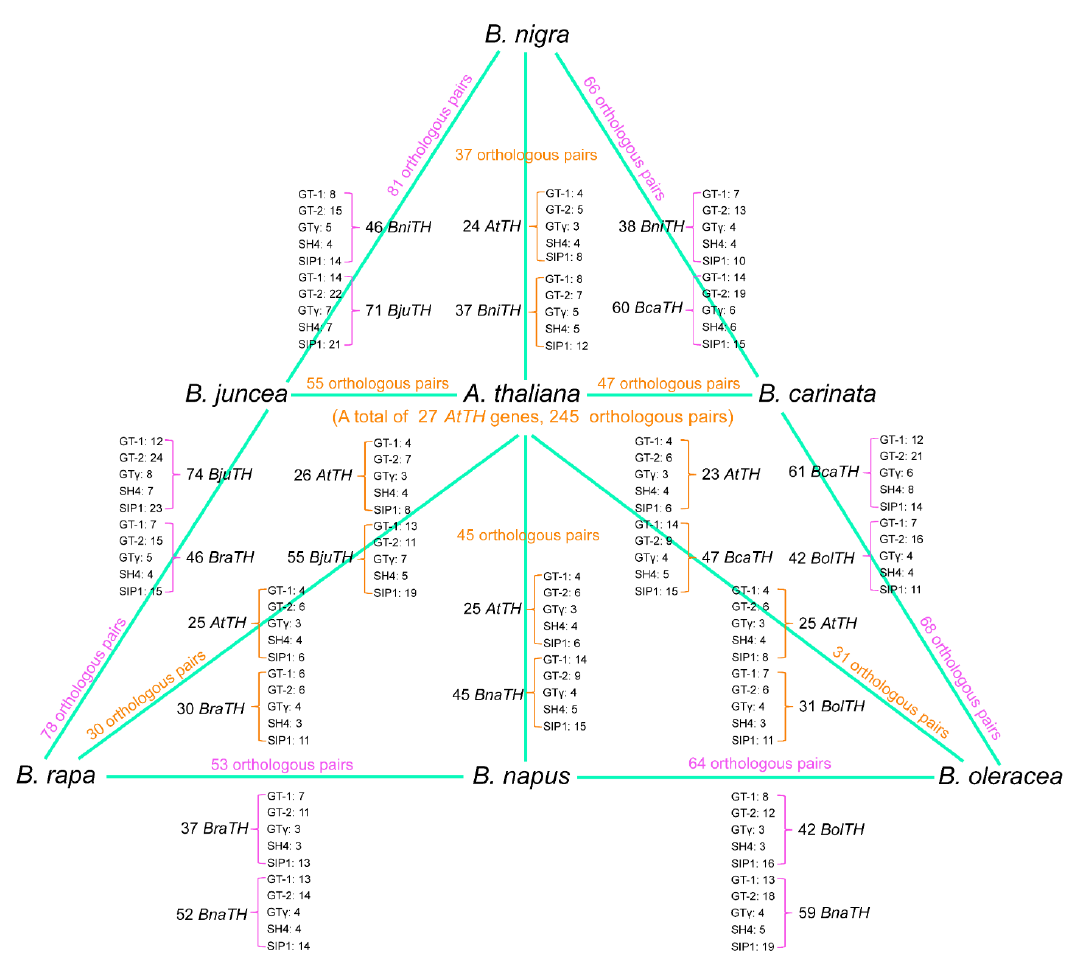
Figure 6. Numbers of orthologous gene pairs among different species and subfamily of orthologous genes. Orange represents the orthologous gene pair between Arabidopsis and Brassica species. Magenta represents the orthologous gene pair between Brassica species.